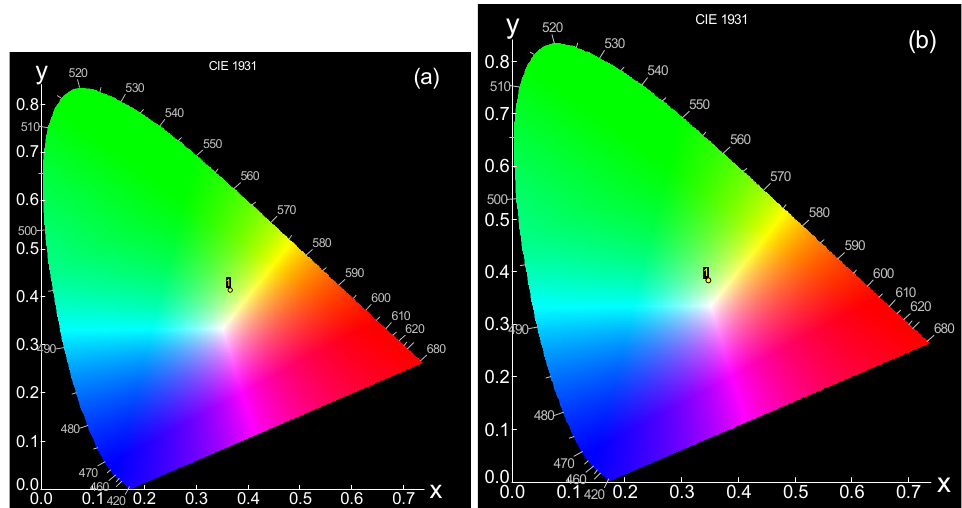
Figure 11. CIE coordinate diagram of ( a ) GRD before irradiation and ( b ) GRD after irradiated with 50 kGy.